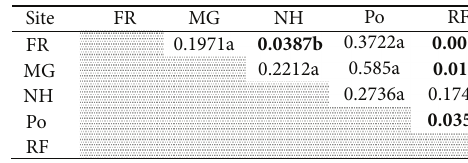
Figure 11: Comparison of Mann-Whitney Statistical test 𝑃 value results for Shannon diversity score (flower diversity) between sites. Significant differences are highlighted in bold, and differences in significance threshold are highlighted by a different